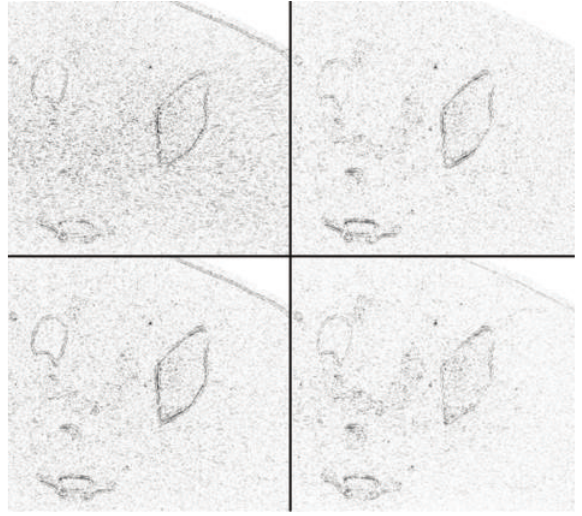
Figure 8: Absolute-valued differences between the reconstructions and the reference image. Darker shade corresponds to a larger error. Left to right, upper to lower: FBP, PWLS, ATM, and our method (stage II).